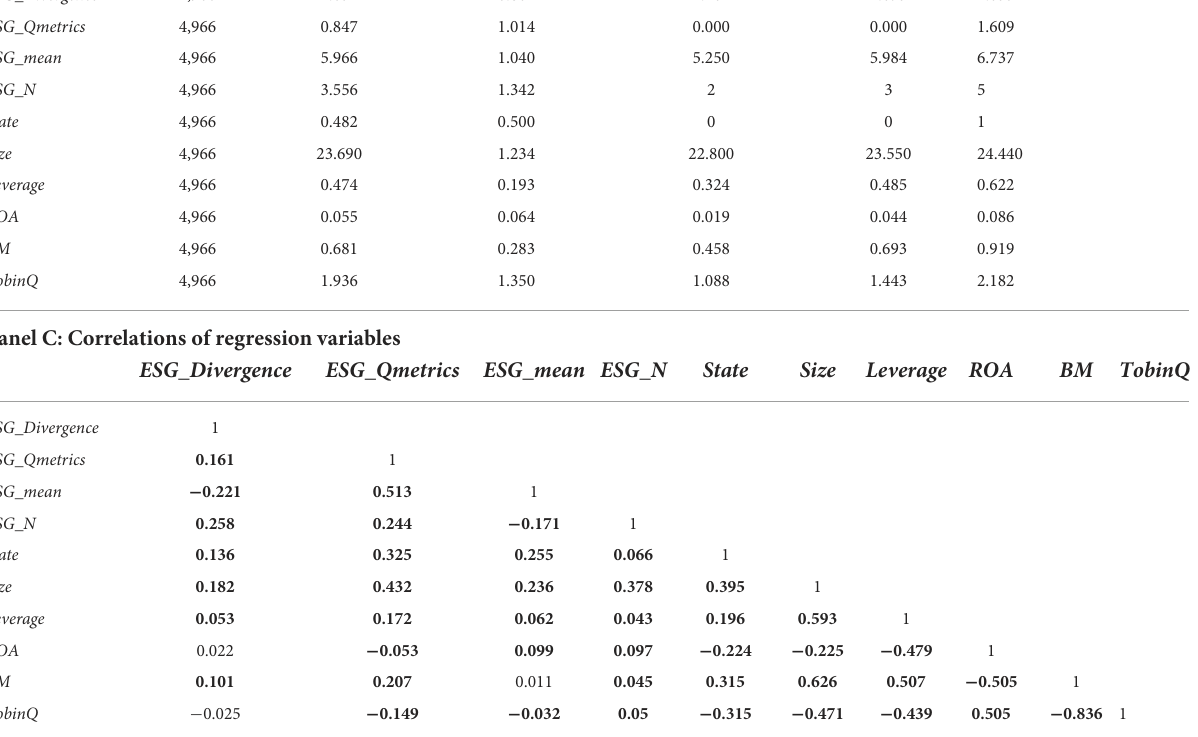
Table 2 Panel C shows the Pearson correlation coefficients of the variables. ESG_Qmetrics , ESG_mean and ESG_N are positively correlated with State and Size , which suggests